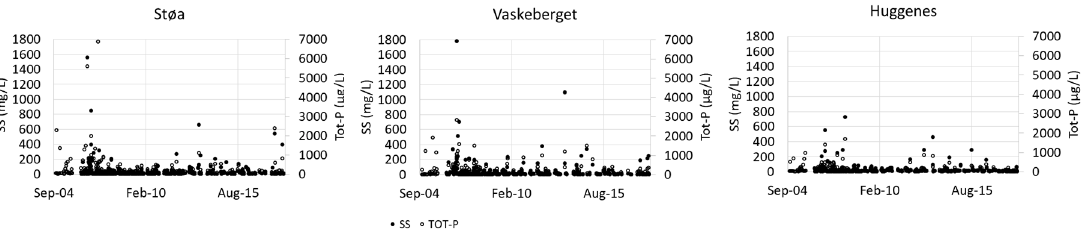
Figure 5. Concentrations of suspended sediments (mg L − 1 ) and total phosphorus (ug L − 1 ) in water samples taken from the six streams during the monitoring period. All samples for Støa, Vaskeberget, and Huggenes.